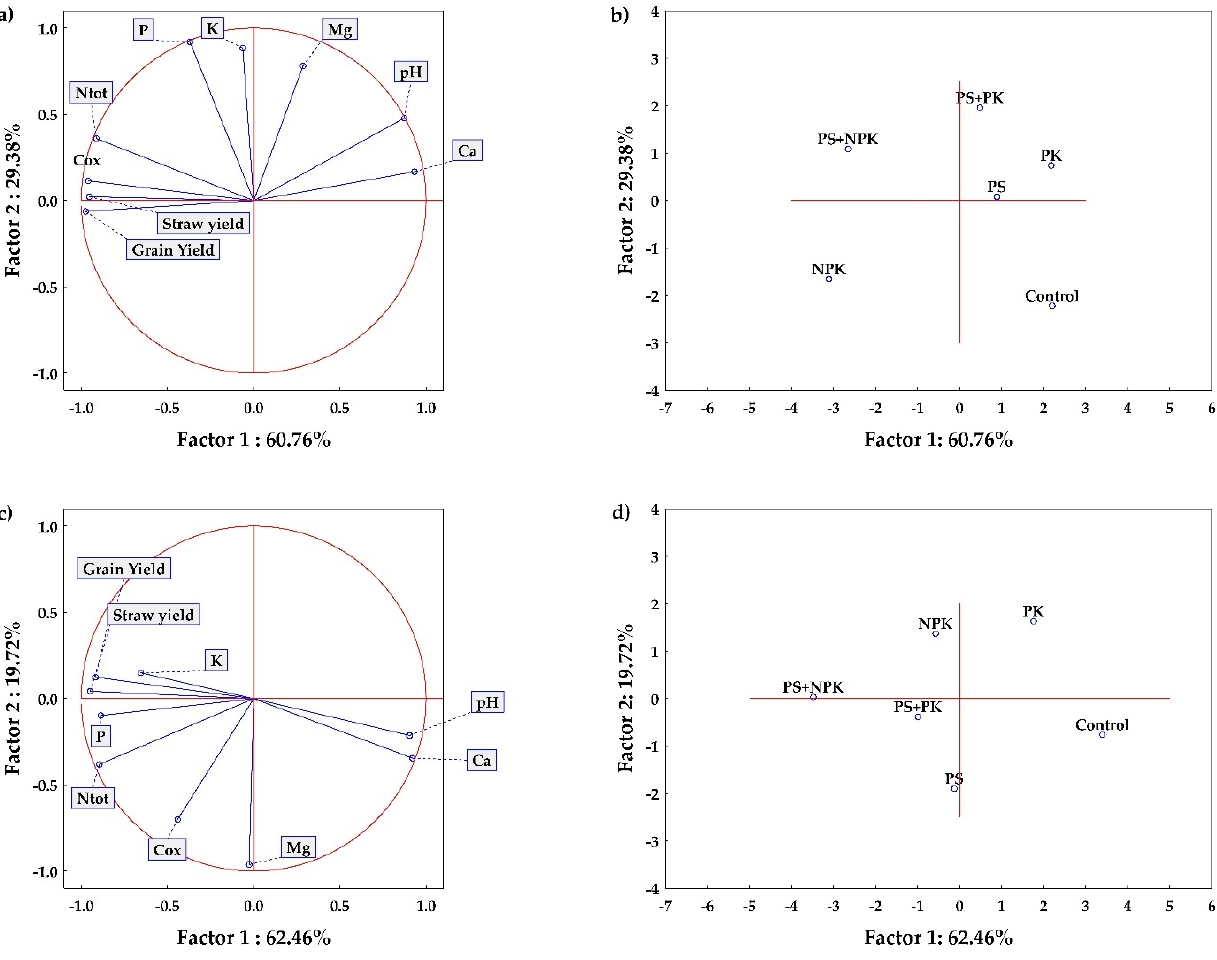
Figure 5. Results of the PCA — relationships between soil chemical parameters and grain and straw yields as affected by the fertilization treatments: ( a , b ) Pernolec, ( c , d ) Kostelec. Grain and straw yields are based on the average WW, SB and FP yield from 2015 to 2020.